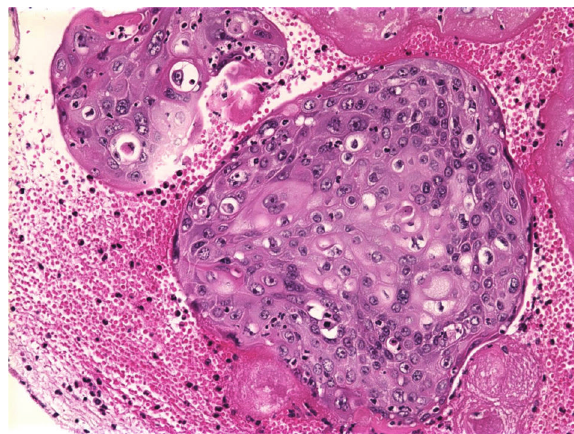
Figure 4: The tumor mass within the right ventricle exhibited features of squamoid di ff erentiation, with extensive associated necrosis secondary to radiation. Additional nests of intravascular squamoid tumor cells within the myocardial vasculature were also